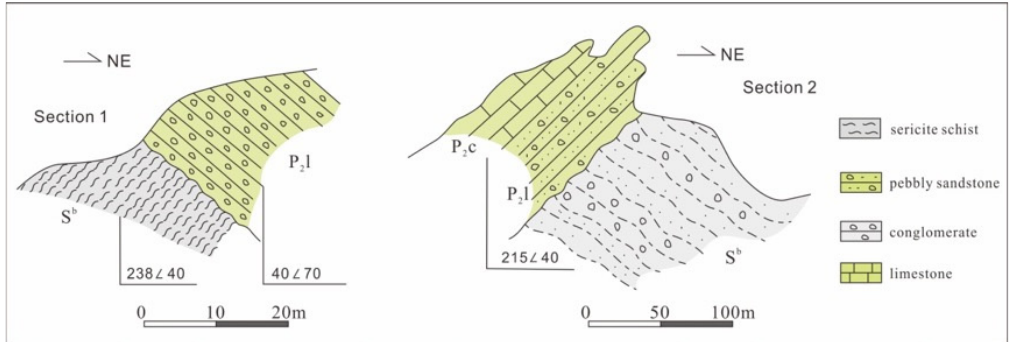
Figure 2. Schematic diagram of the structural and stratigraphic in sections (section locations are shown in Figure